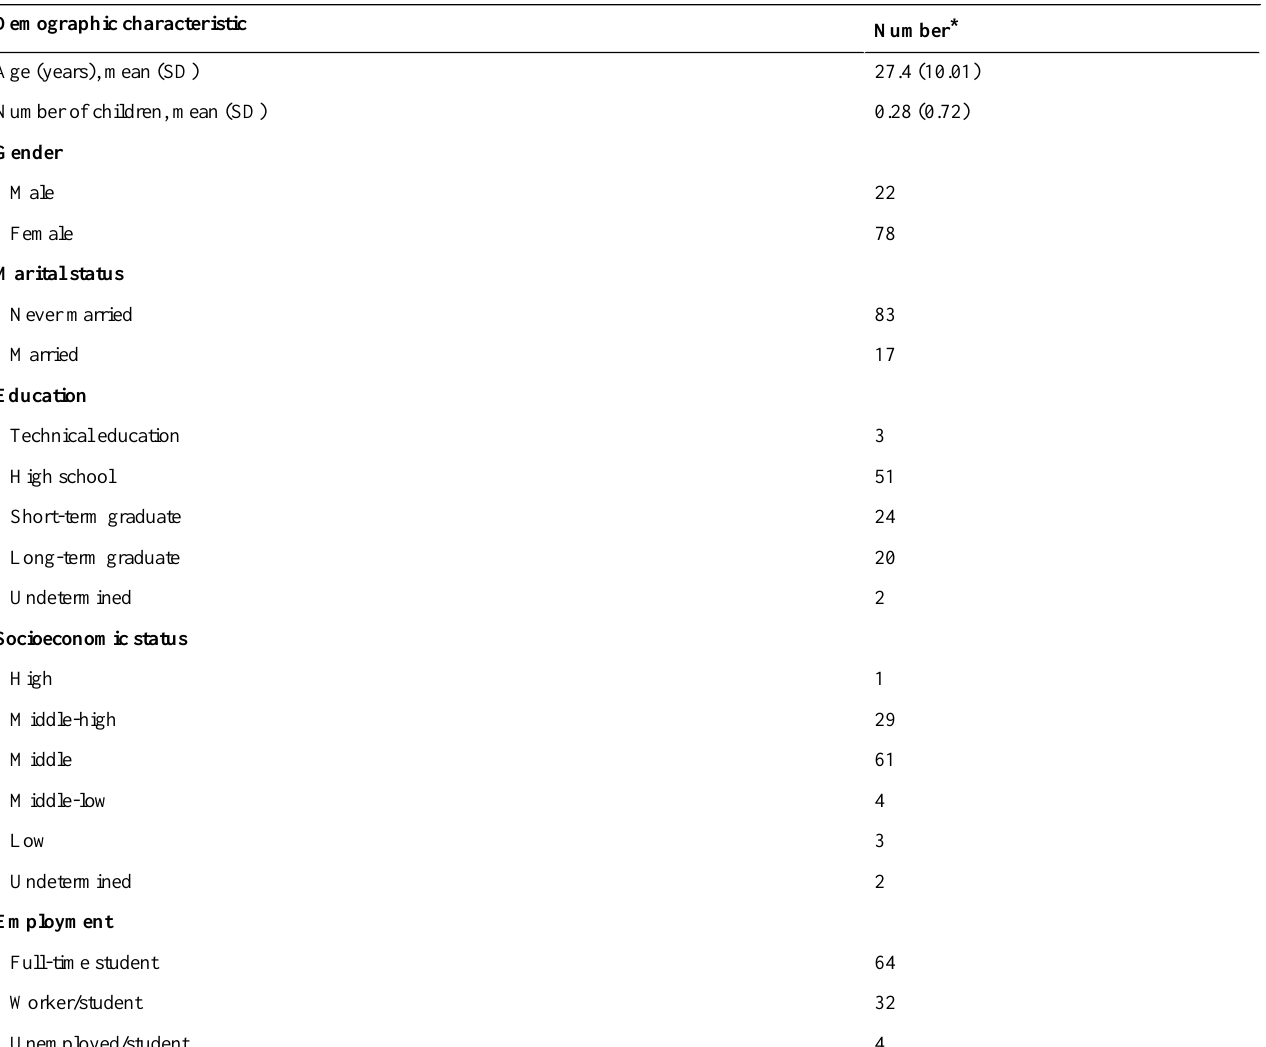
Table 1. Demographic characteristics of the participants who completed all questionnaires, N = 100